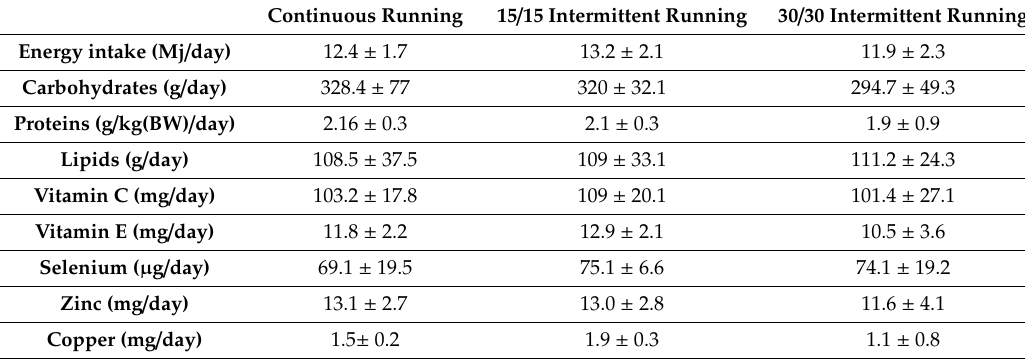
Table 1. Total daily energy intakes, and macronutrient and antioxidant micronutrient consumption during the period of the three di ff erent running exercise modalities (mean ± SD).